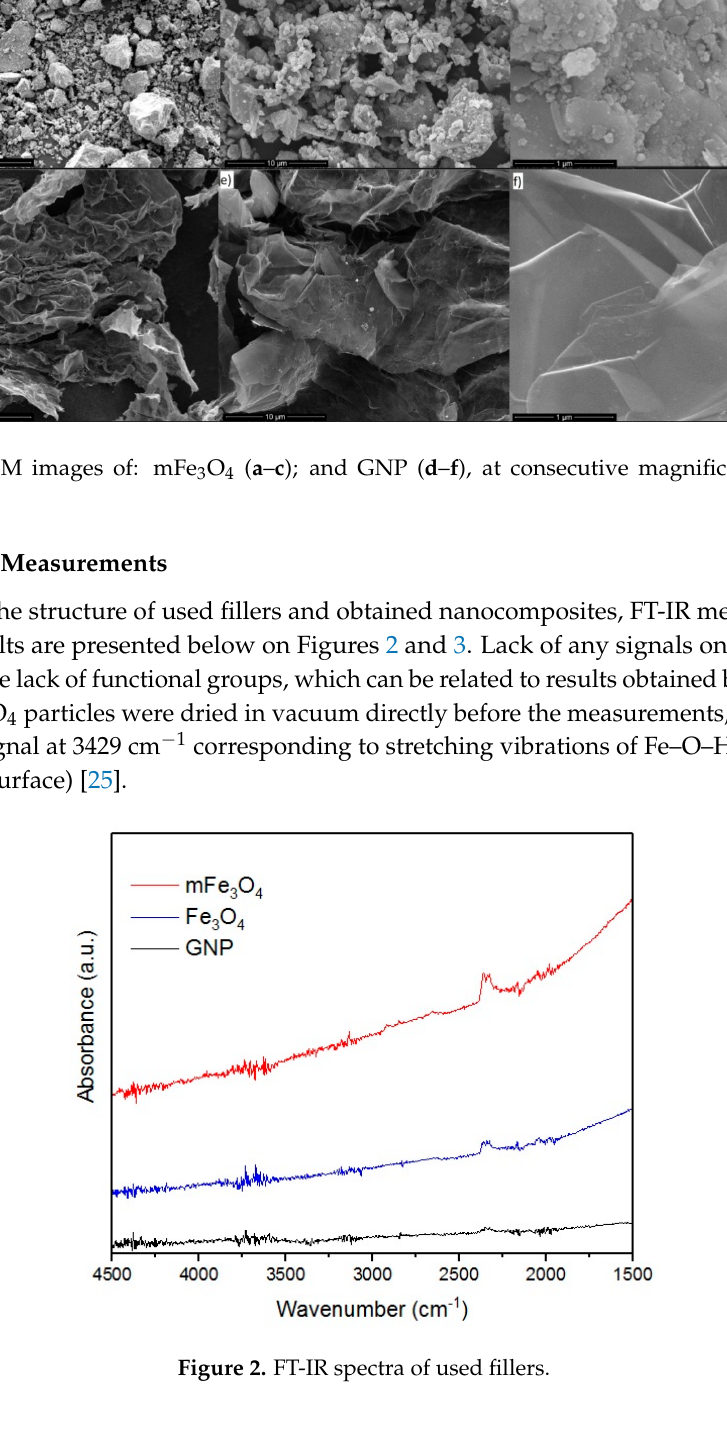
Figure 2. FT-IR spectra of used fillers.